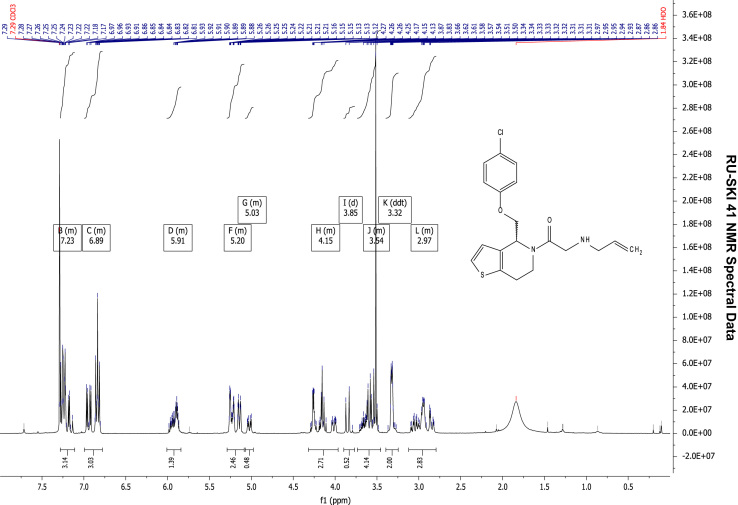
1H NMR (400 MHz, CDCl3) of RU-SKI 41
(9a).